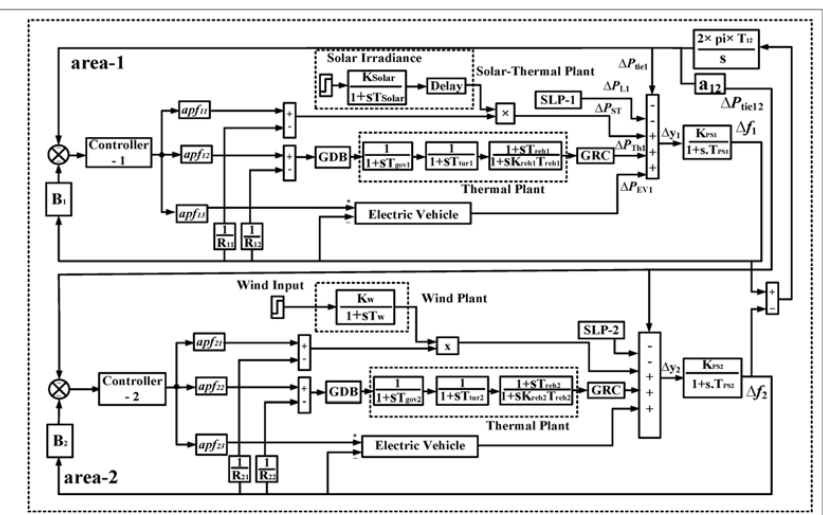
Figure 11. Two-Area power system with Wind, Thermal and Solar Thermal Plants as well as EVs.